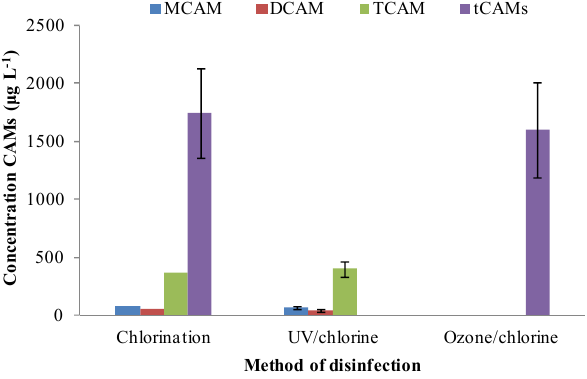
Figure 5. Mean and standard deviation of CAMs with different methods of disinfection. Note: a statistical analysis to compare the means was not carried out because of fewer data points.